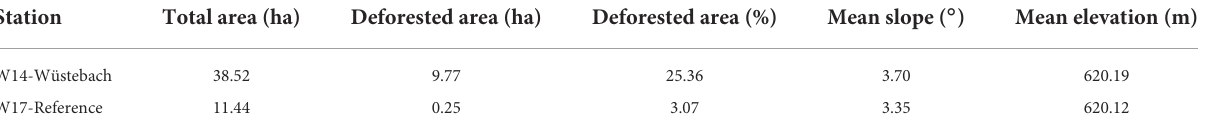
TABLE 1 Characteristics of both catchments indicating area, extent of deforestation, slope and